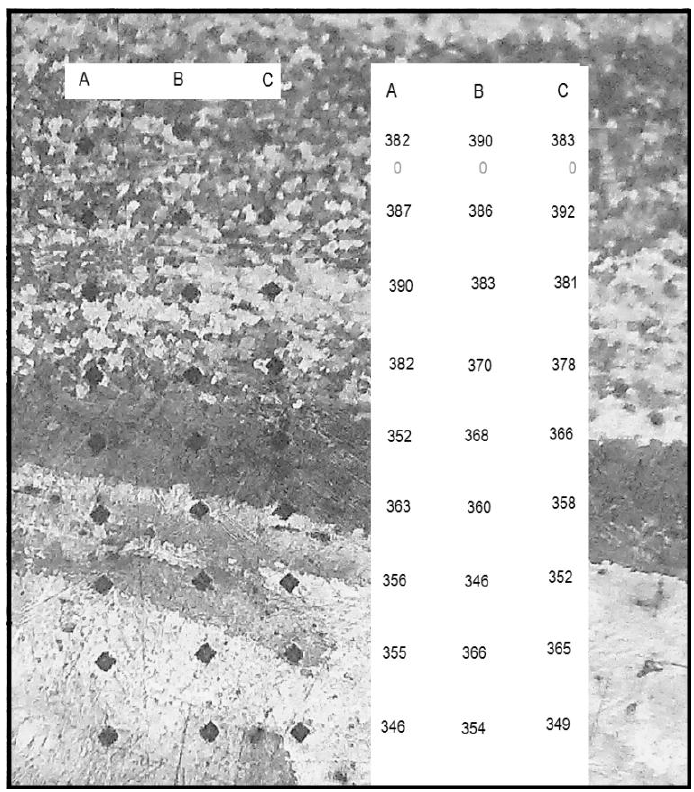
Figure 6. The hardness values of welded samples for 7 s.